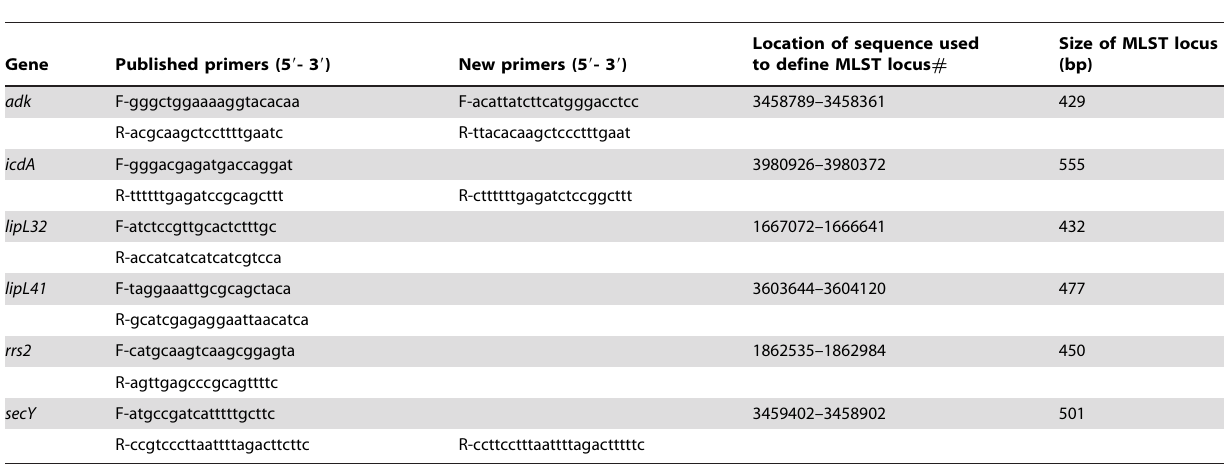
Table 2. Primers for 6 locus genotyping scheme used during this study [39].